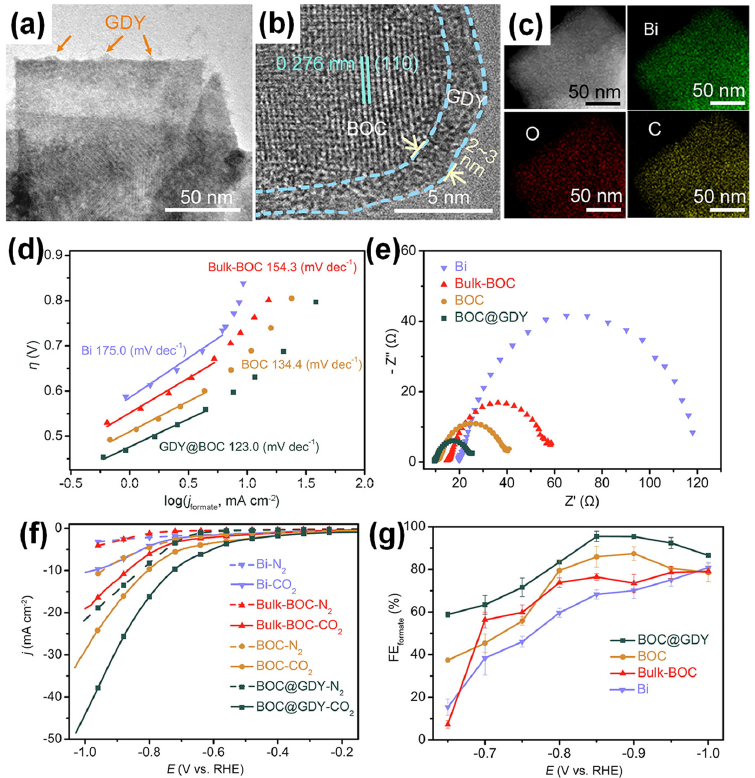
Figure 5. ( a ) TEM, ( b ) HRTEM, and ( c ) HAADF-STEM and element mapping images for BOC@GDY. Study for the influence of GDY and the catalytic mechanism of BOC@GDY for ECR. ( d ) Tafel plots and ( e ) Nyquist plots at − 0.45 V vs. RHE for commercial Bi, bulk-BOC, BOC, and BOC@GDY in H-type cell; ( f ) LSV curves for commercial Bi, bulk-BOC, BOC and BOC@GDY; ( g ) FEs for formate over commercial Bi, bulk-BOC, BOC, and BOC@GDY [44]. Copyright 2021, Elsevier.